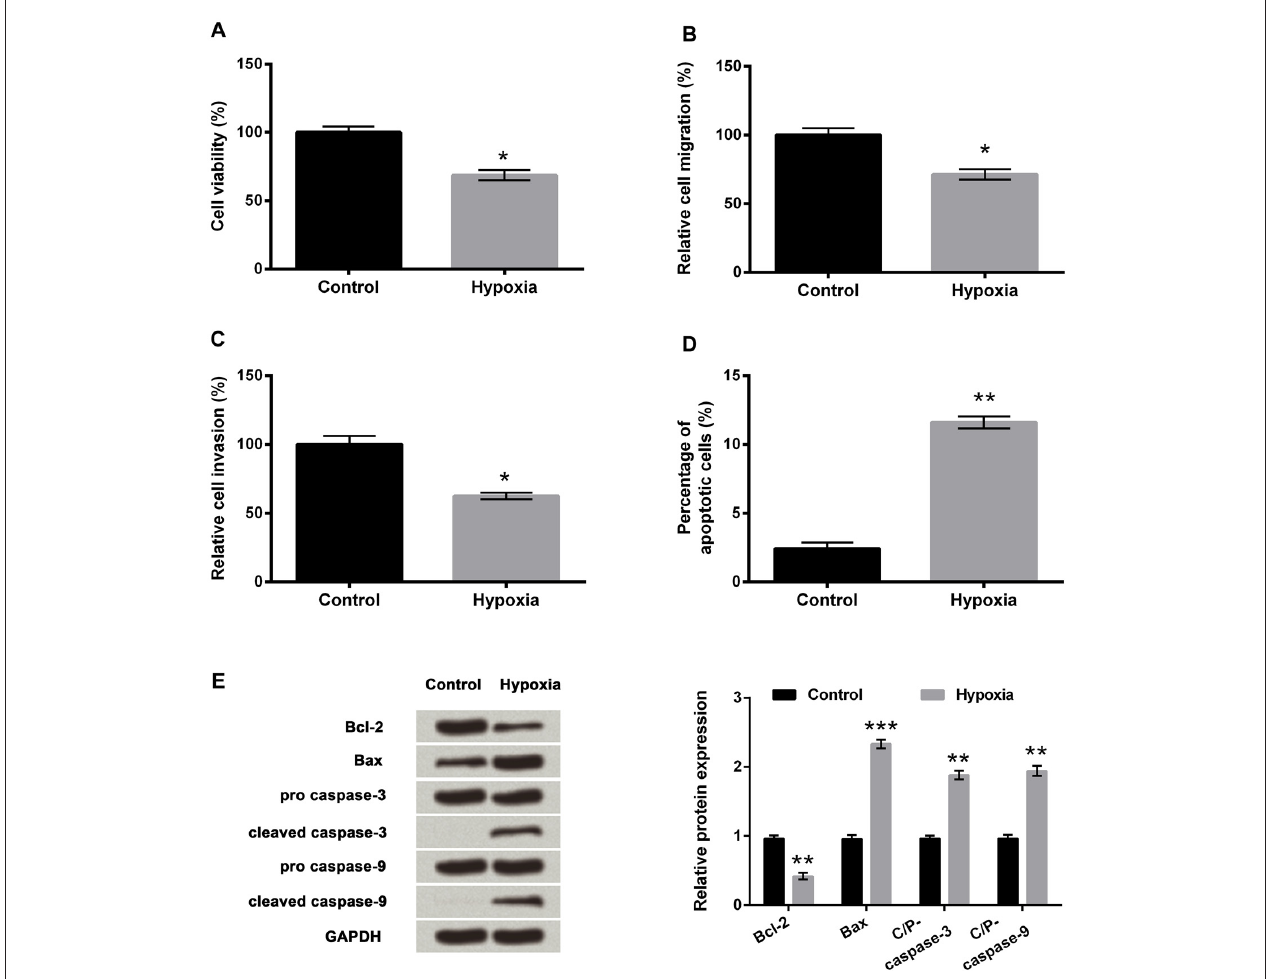
FIGURE 1 | PC-12 cell injury induced by hypoxia. (A–D) Effects of hypoxia treatment on cell viability, migration, invasion and apoptosis. (E) Western blotting analysis of apoptosis-related factors. Data presented are the mean ± SEM of at least three independent experiments. ∗ P < 0.05; ∗∗ P < 0.01; ∗∗∗ P < 0.001. Bcl-2, mammalian B cell lymphoma-2; Bax, Bcl-2-associated X protein; C/P-,